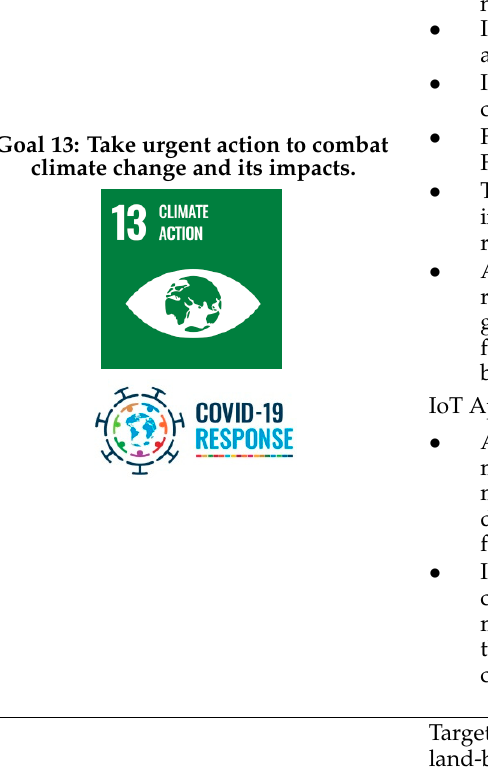
Goal 1: End poverty in all